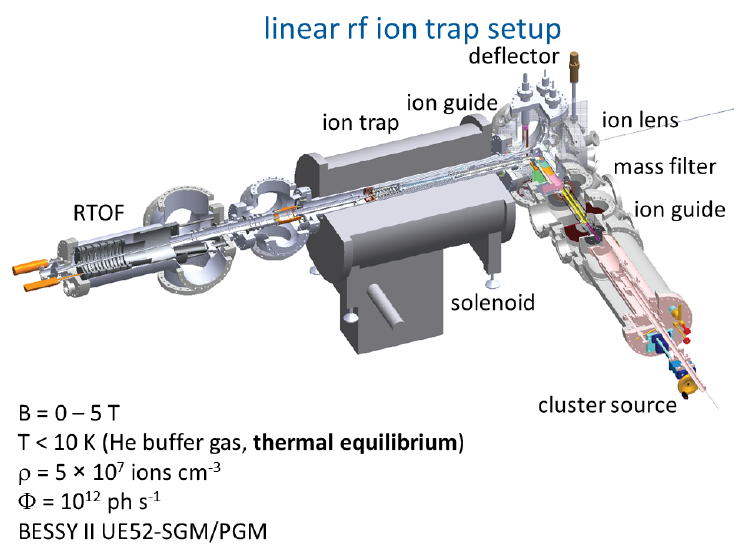
Figure 2: Schematic view of the Nanocluster Trap endstation with sample preparation (cluster source, ion guide/collision cell, and mass filter) and spectroscopy (ion trap, superconducting solenoid, and reflectron time-of-flight mass spectrometer)